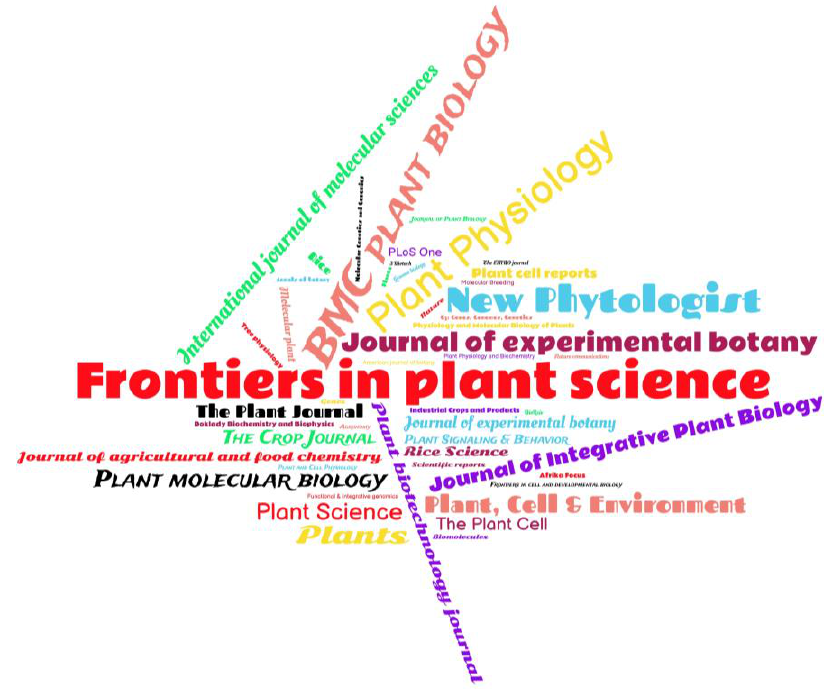
Figure 3. Word cloud of the journals that published the most on CRISPR/Cas being used to edit genes for tolerance to abiotic stresses in plants in the last seven years.